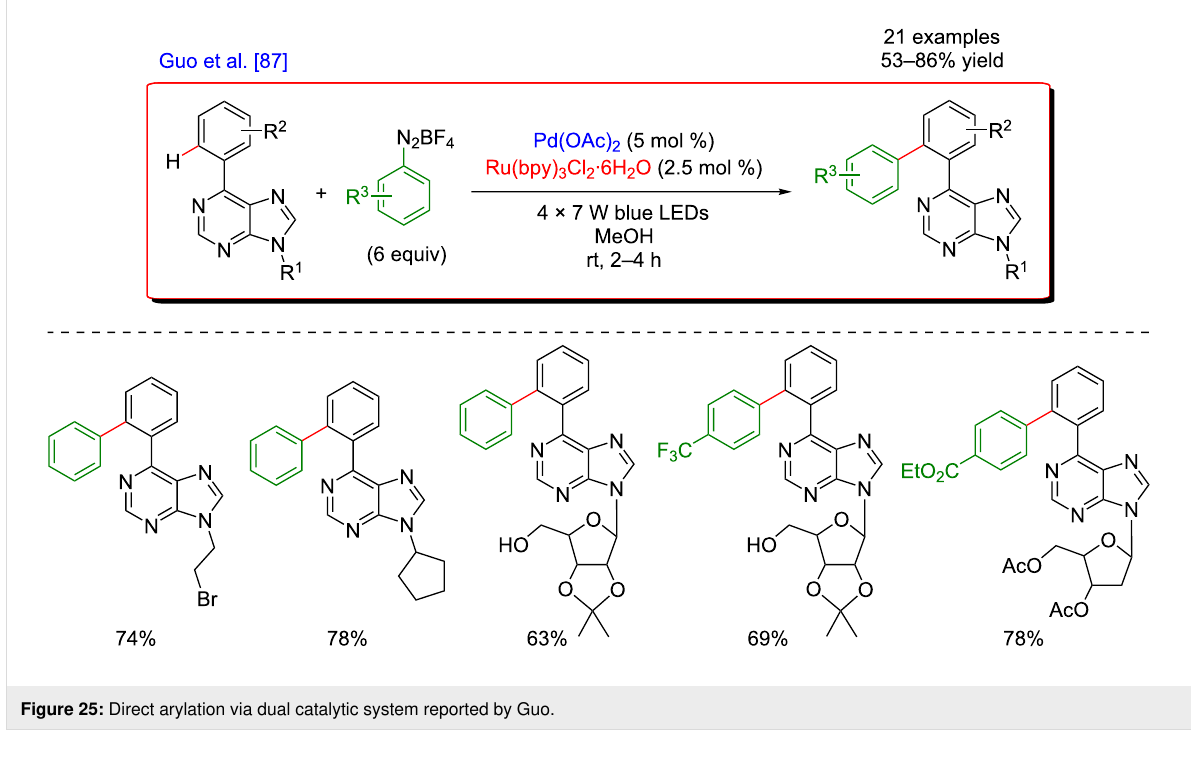
Figure 25: Direct arylation via dual catalytic system reported by Guo.